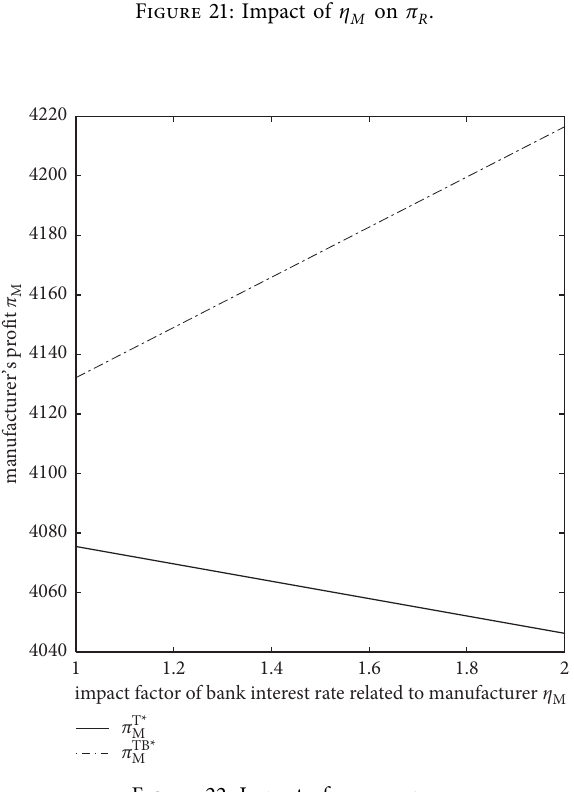
Figure 21: Impact of η M on π R .